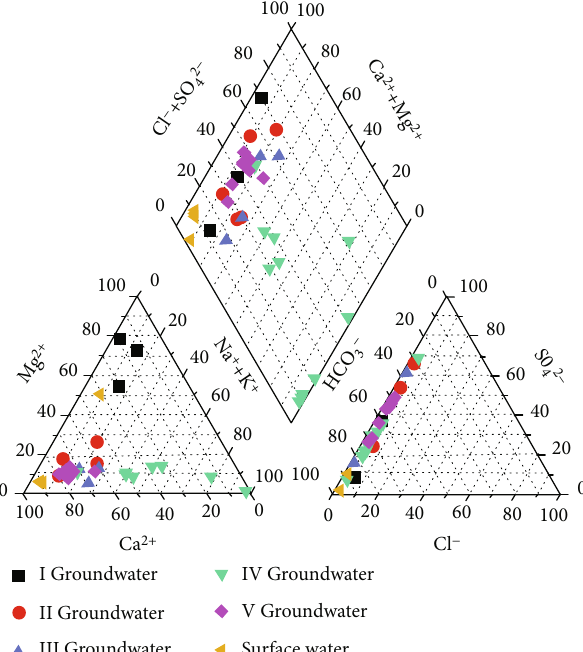
Figure 4: Pipper three-line diagram of the study